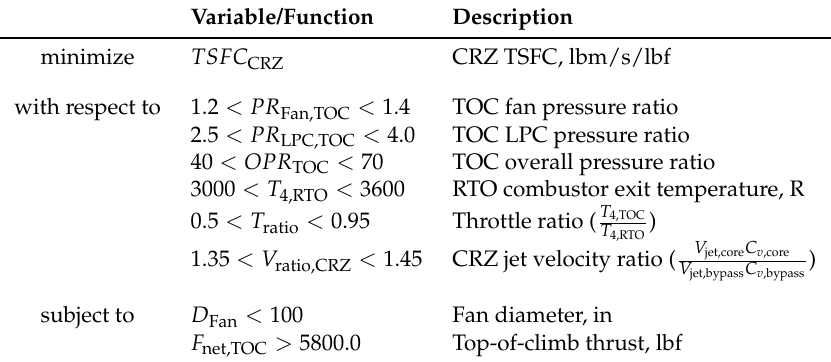
Table 6. Optimization problem